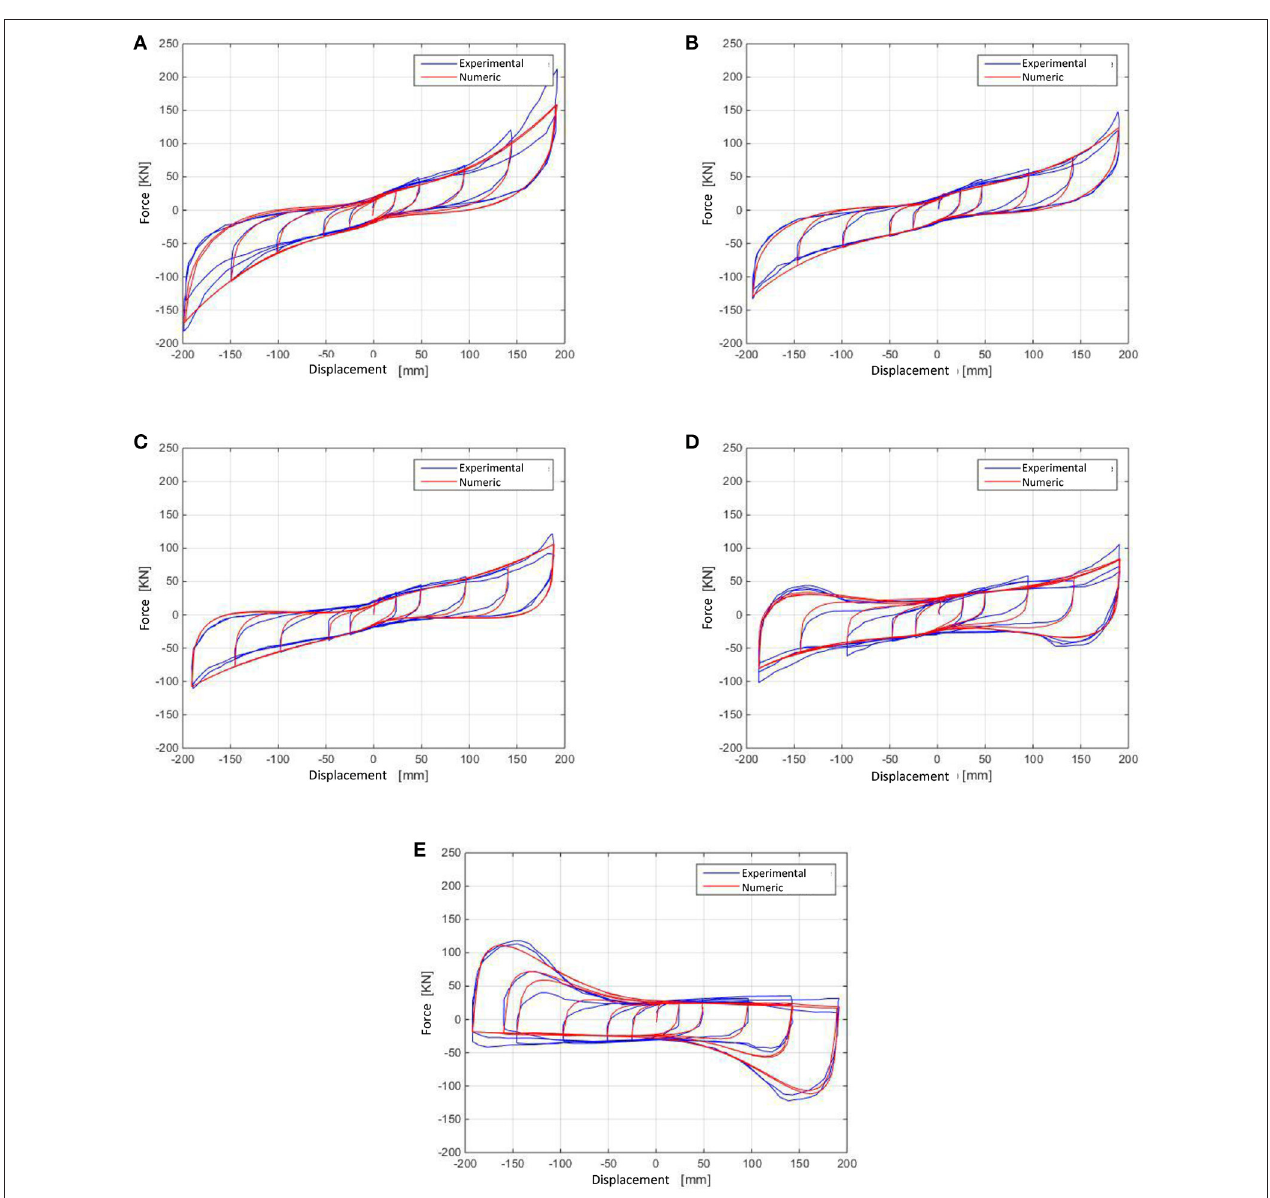
FIGURE 5 | Genetic Algorithm method: cyclic shear test of the tested isolator (50, 100,200, 300, and 400% deformations for compression stresses of 0 MPa (A) , 5 MPa (B) , 10 MPa (C) , 20 MPa (D) , 30 MPa (E) . Comparison between model (parameters in Table 4 ) and experimental and experimental results.